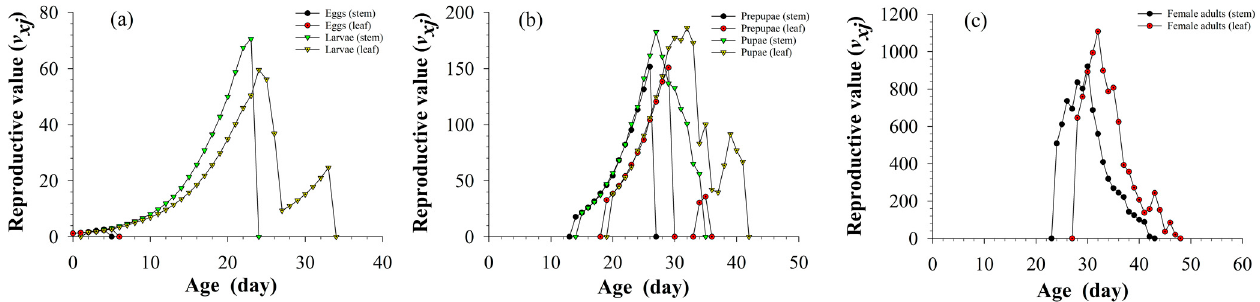
Figure 4. Age-stage-specific reproductive value ( v xj ) of eggs and larvae ( a ), prepupae and pupae ( b ), female adults and male adults ( c ) of S. litura fed on different tissues of asparagus.